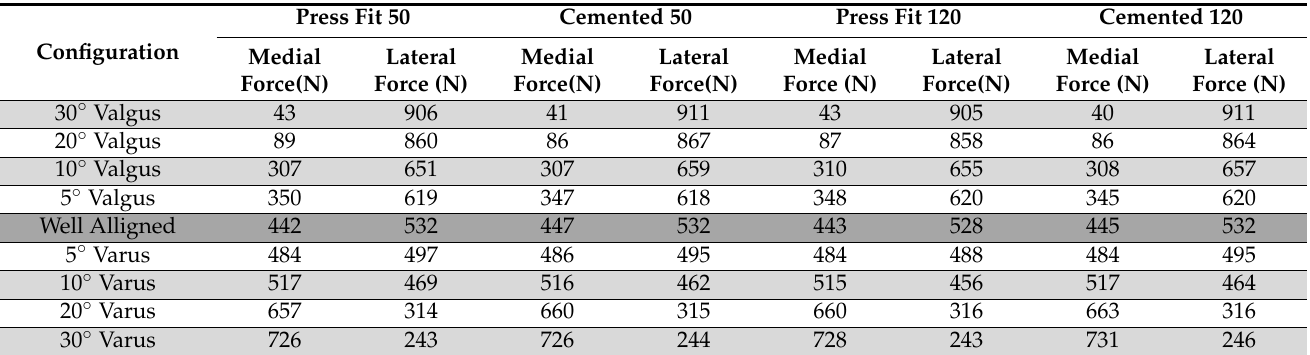
Table 4. Medial and lateral contact forces for the different configurations and for different stem lengths and cementing techniques.